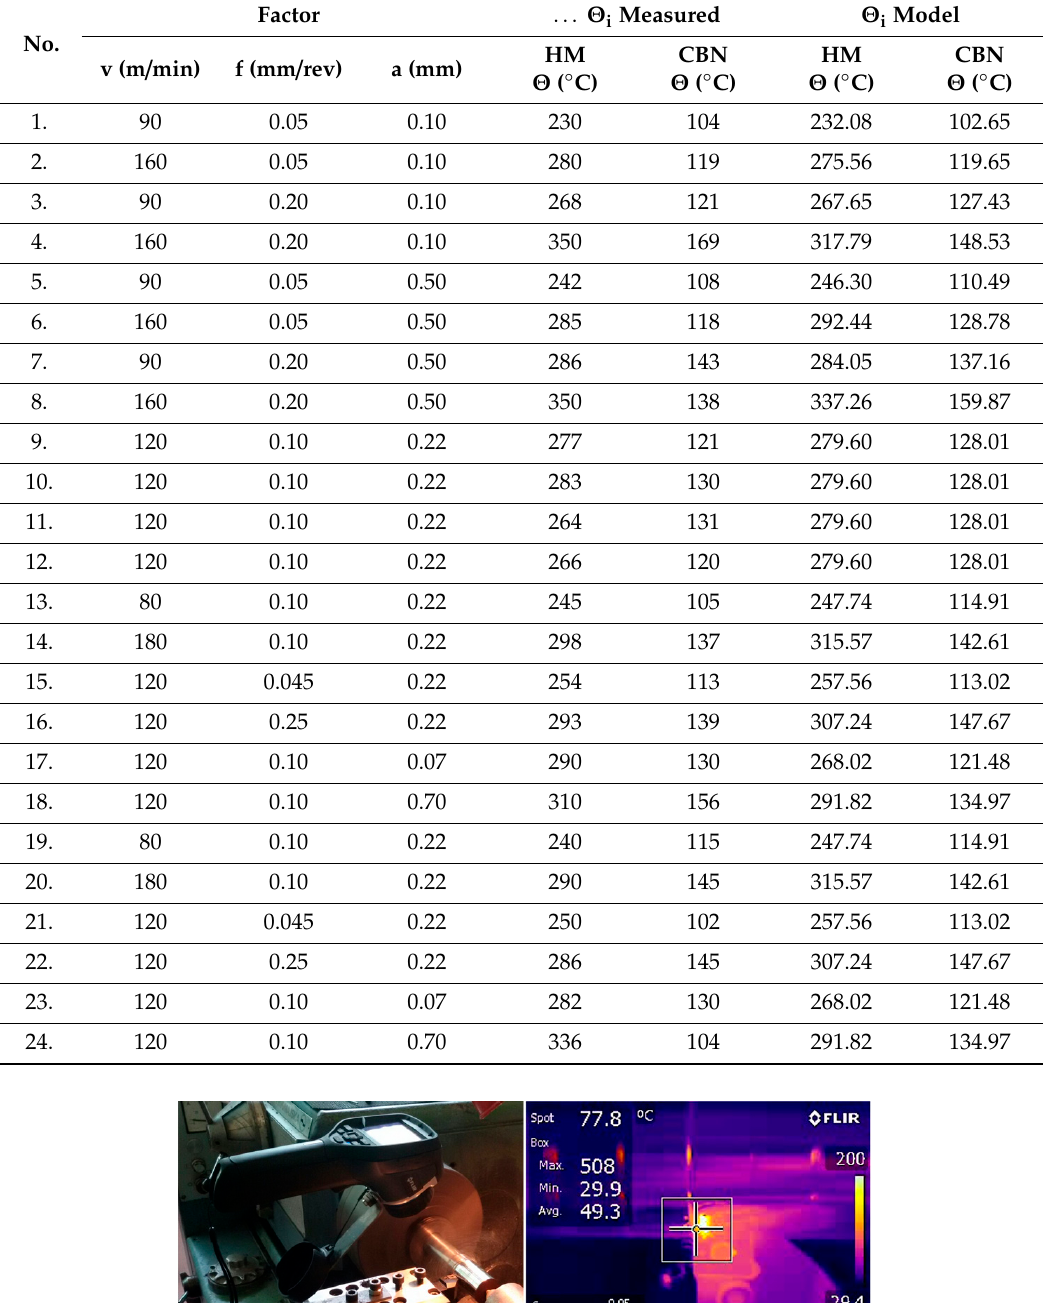
Table 4. The measurement and modelled RSM results—input parameters.